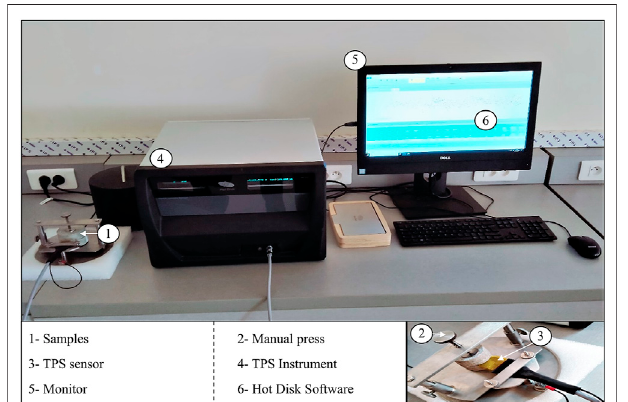
FIGURE 4 | Compressive strength test (A) and failure of CEP6 (B) .